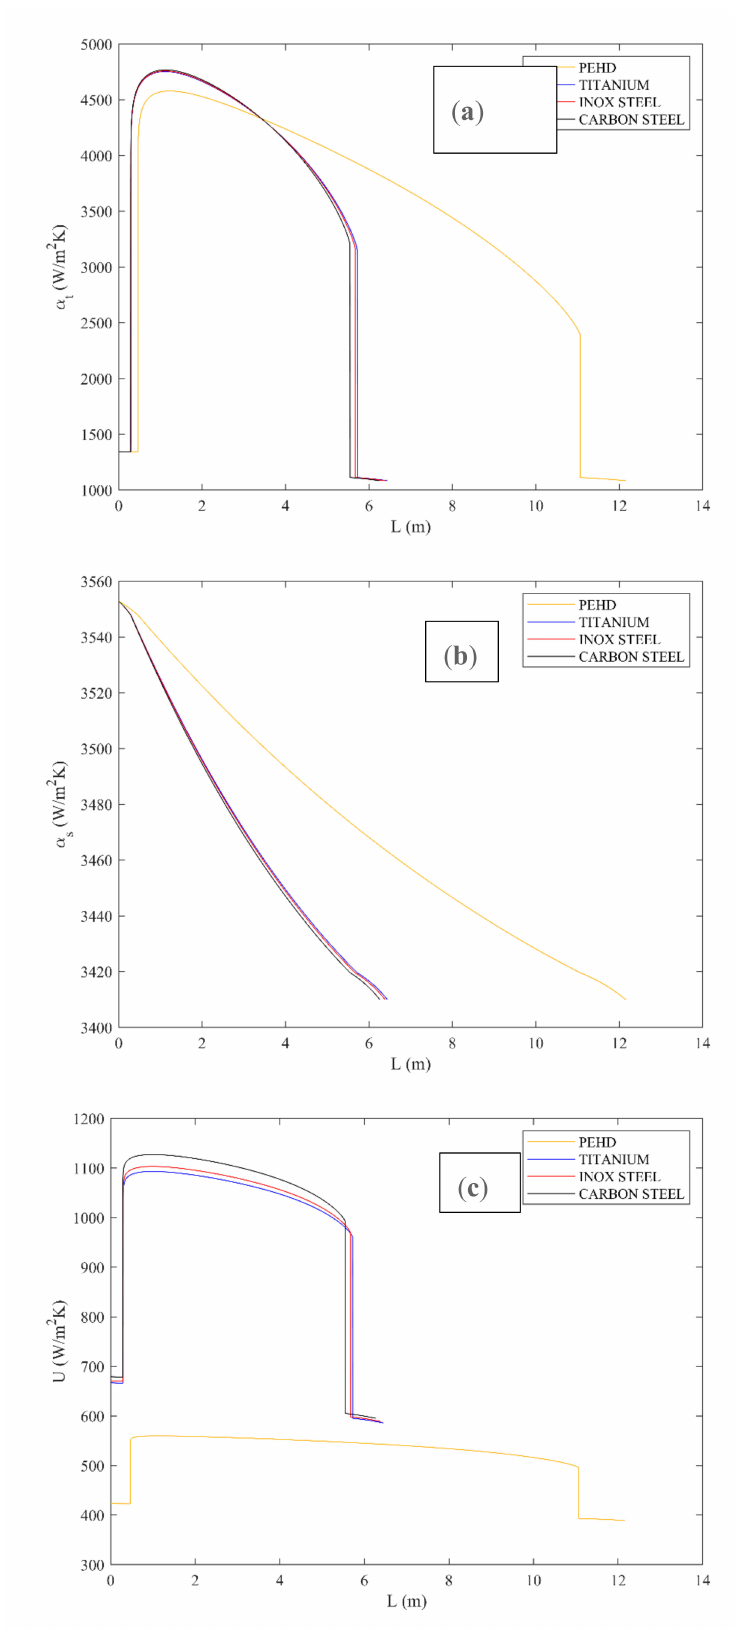
Figure 7. Convective heat transfer coe ffi cient on tube side ( a ) and shell side ( b ) and overall heat transfer coe ffi cient ( c ) as a function of evaporator